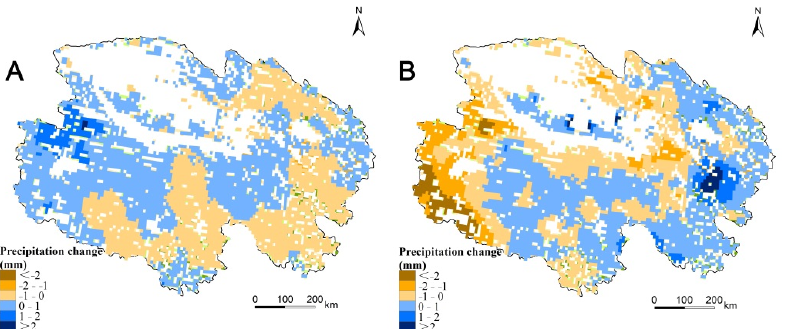
Figure A2. Annual precipitation change in the Qinghai grasslands from 1979 to 2000 ( A ) and from 2001 to 2018 ( B ).